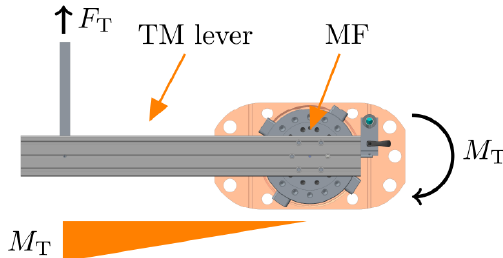
Figure 6. Working principle of LS2.